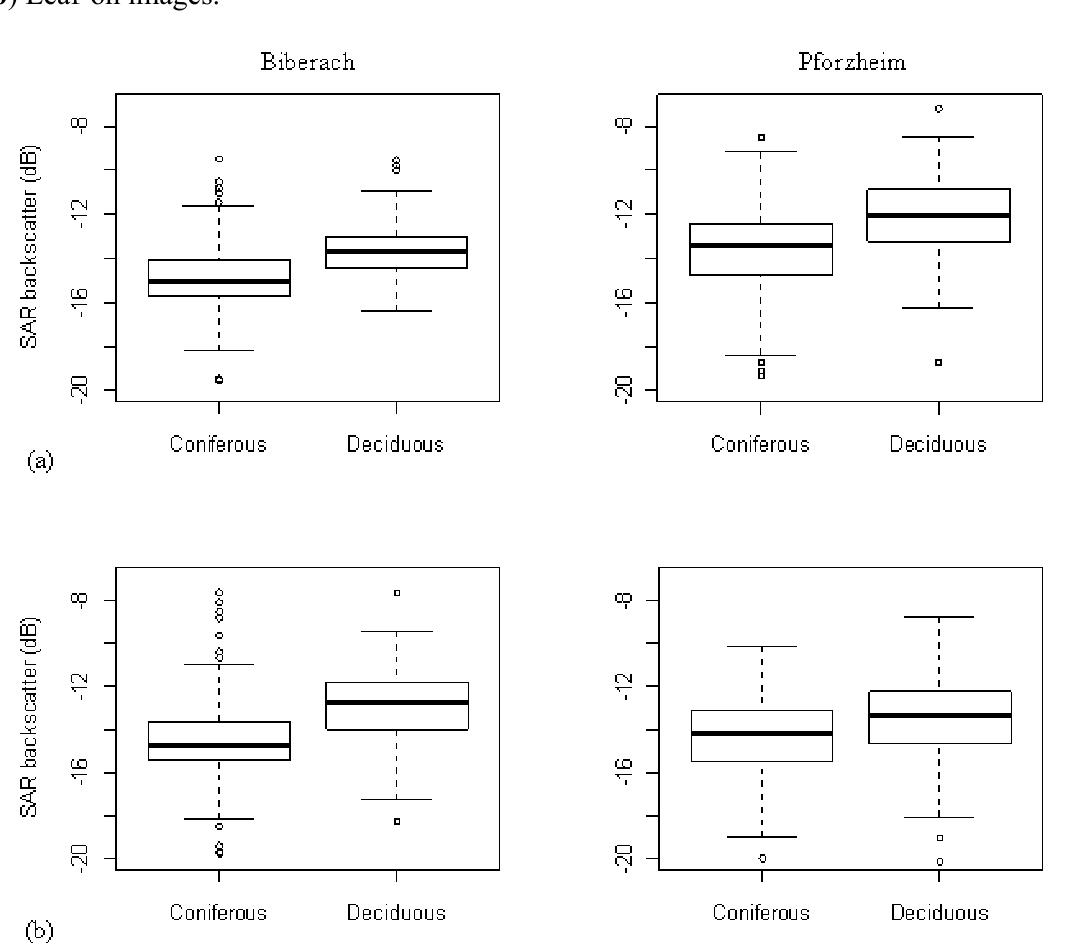
Figure 4. Boxplots of SAR backscatter ( σ 0 ) on sample plots dominated by coniferous or deciduous trees in images preprocessed with ALS DSMs. ( a ) Leaf - off images and ( b ) Leaf-on